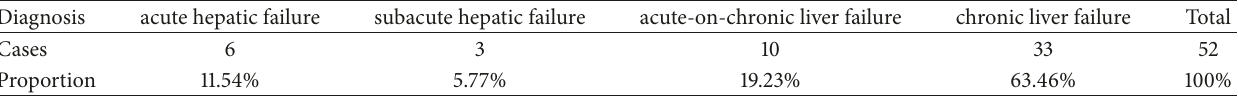
Table 1: Diagnosis and classification of liver failure.